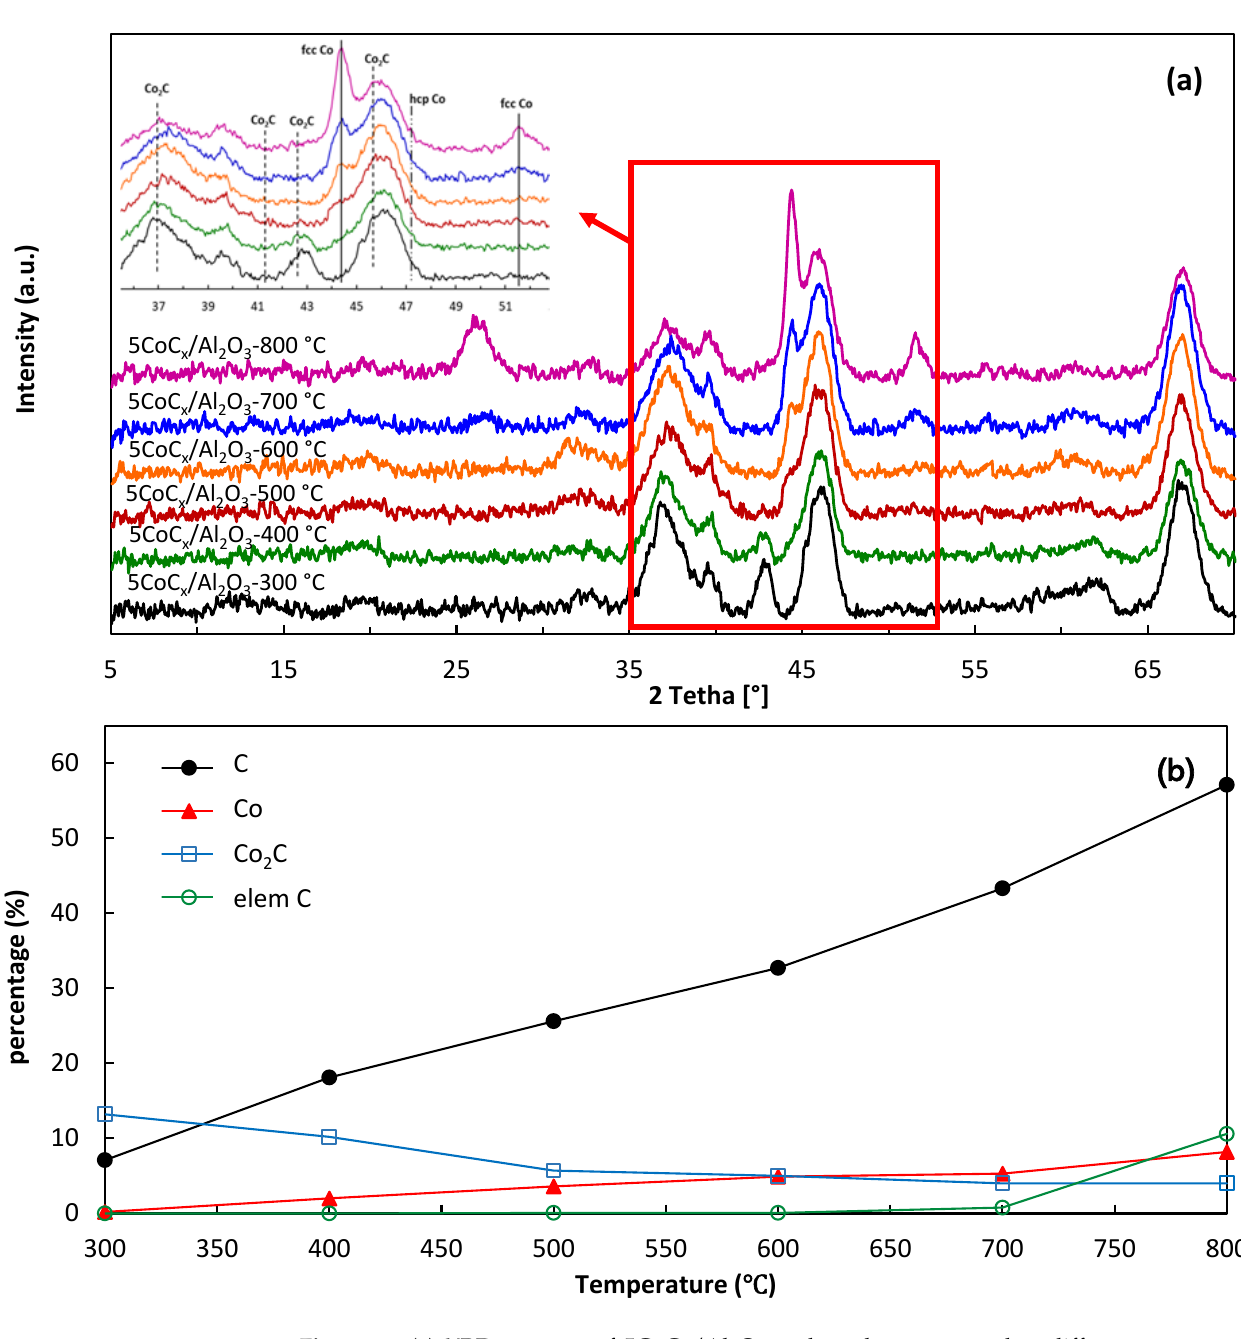
Figure 2. ( a ) XRD patterns of 5CoC x /Al 2 O 3 and catalysts prepared at different temperatures, ( b ) Content of individual phases according to SQ performed from XRD spectra (C-carbon, Co-cobalt, Co 2 C-carbide) and carbon content determined by elemental analysis (elemC).